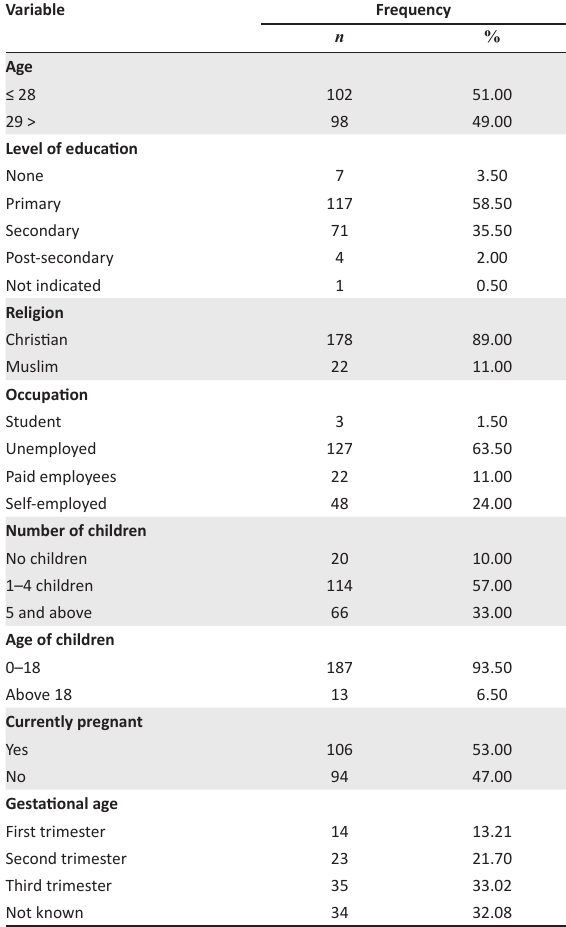
TABLE 1: Demographic characteristics of the participants.